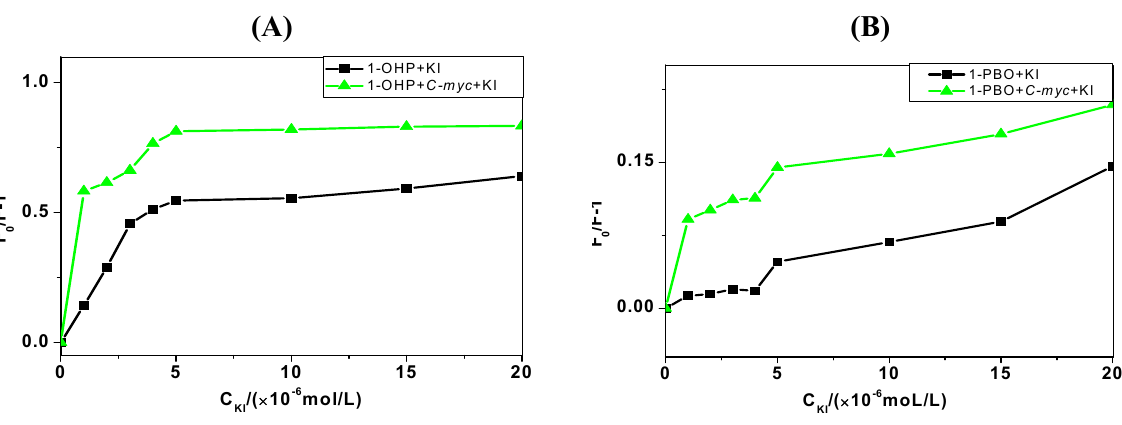
Figure 4. Quenching extents of pyrene derivatives solutions (1  mol/L) with the addition of KI (0–20  mol/L) in the absence and presence of C-myc DNA (10  mol/L). ( A ) 1-OHP and ( B ) 1-PBO.